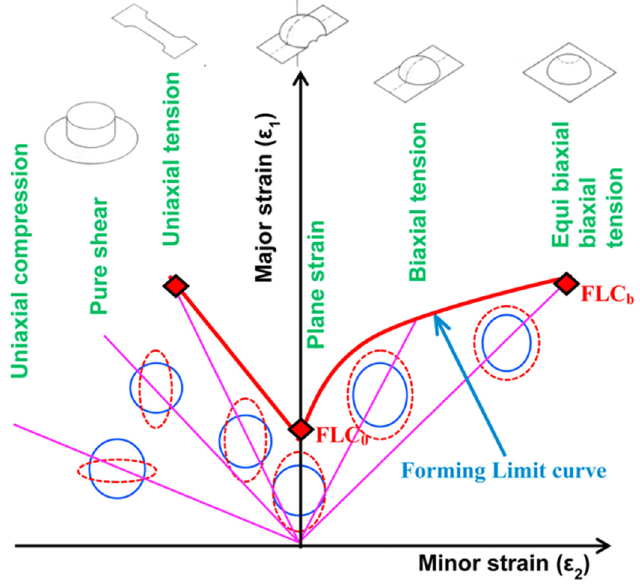
Figure 25. A schematic description of FLD and other failure limits. Reprinted from Ref. [325] with permission. Copyright 2016, Elsevier.